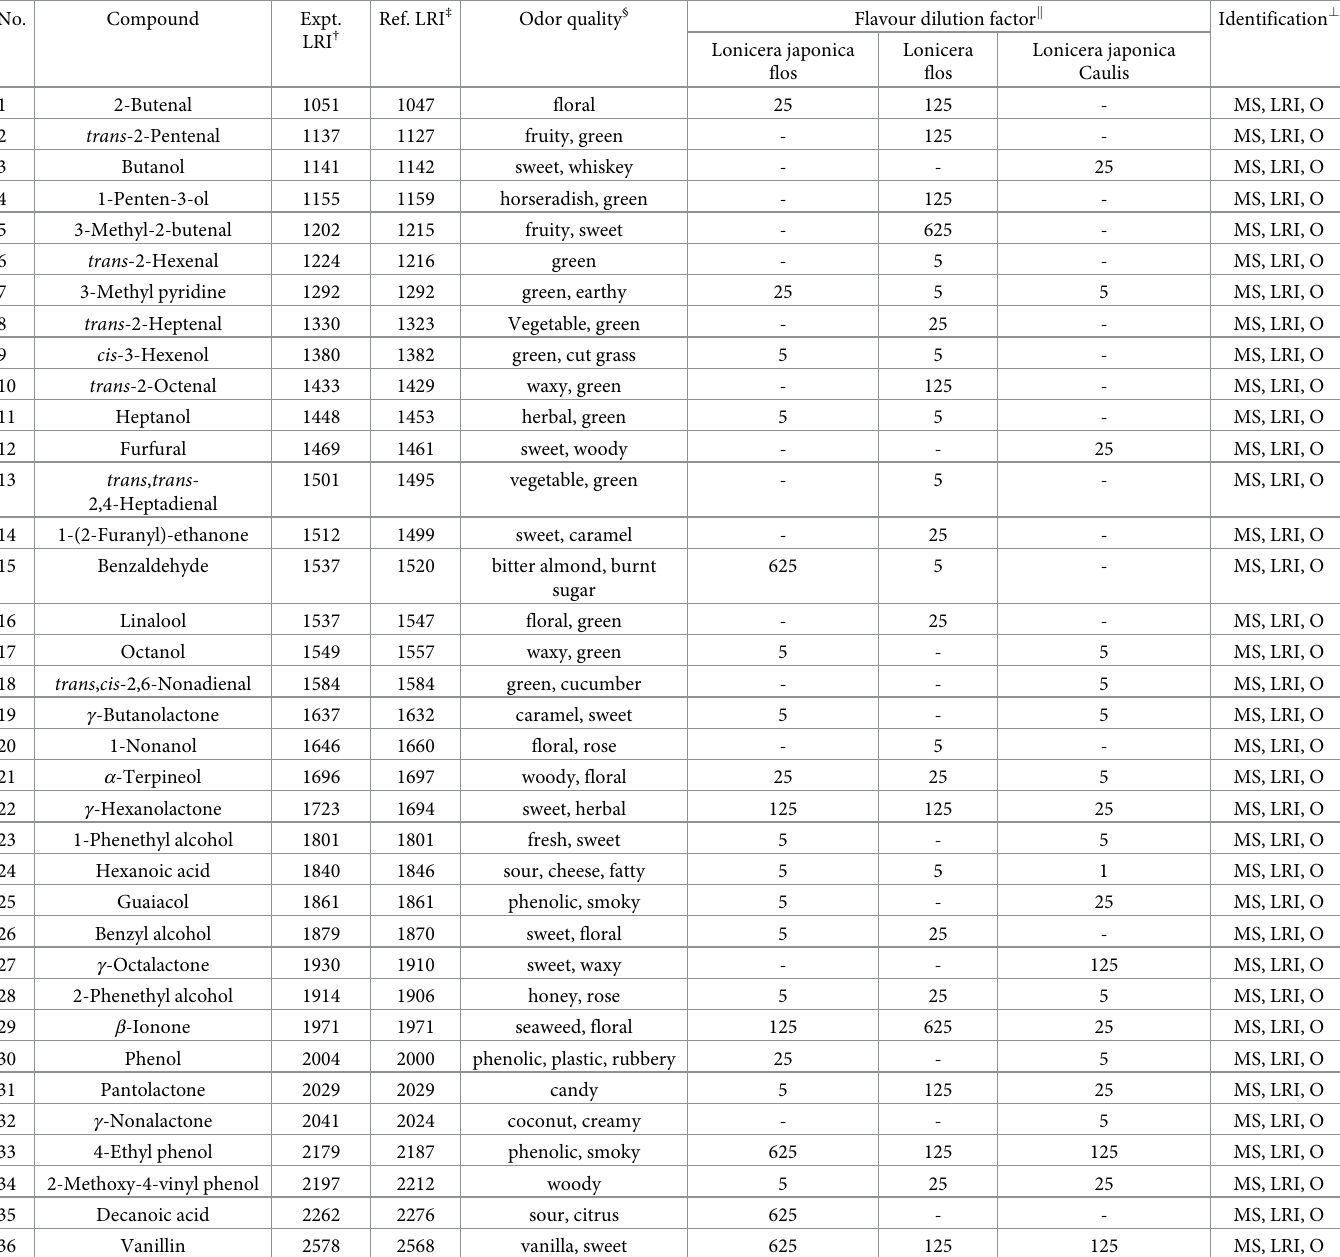
Table 1. Key odorants (flavour dilution factor � 1) with their respective flavour dilution factors in SAFE extracts of Lonicera japonica Flos , Lonicera Flos and Loni- cera japonica Caulis . Olfactometric detection was conducted by four